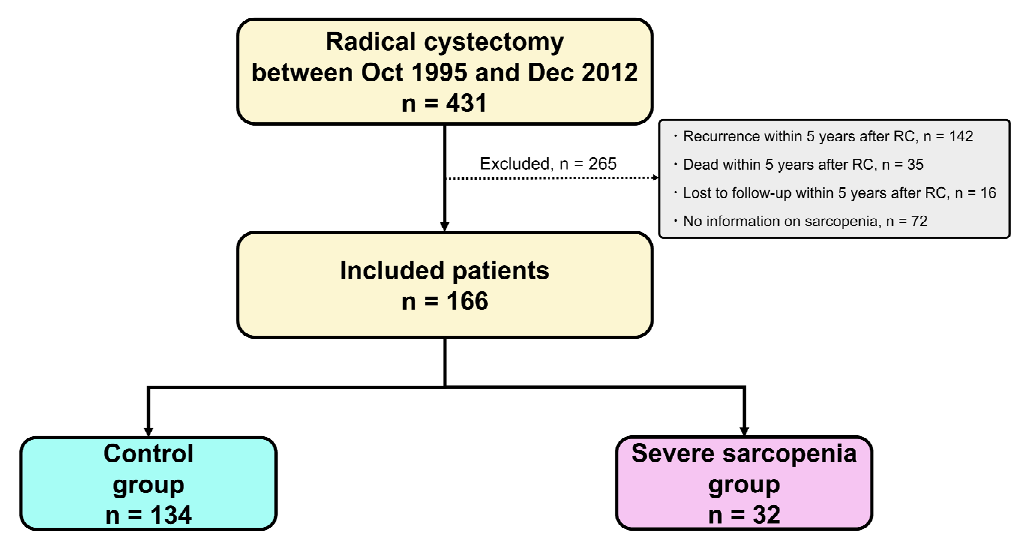
Figure 1. Patient selection. The numbers of patients included and excluded from the present study are shown. RC, radical cystectomy.